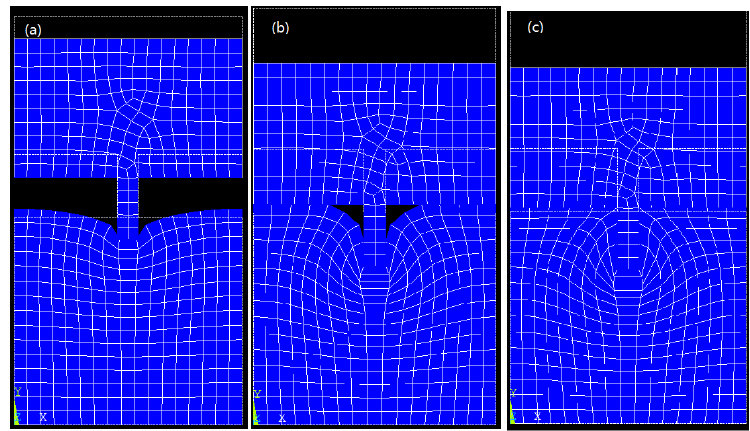
Figure 2. Positive-mold-filling ratio for an aspect ratio of 3:1 increasing with imprinting pressure: ( a ) 1 × 10 8 , ( b ) 5 × 10 8 , and ( c ) 1.4 × 10 9 Pa.